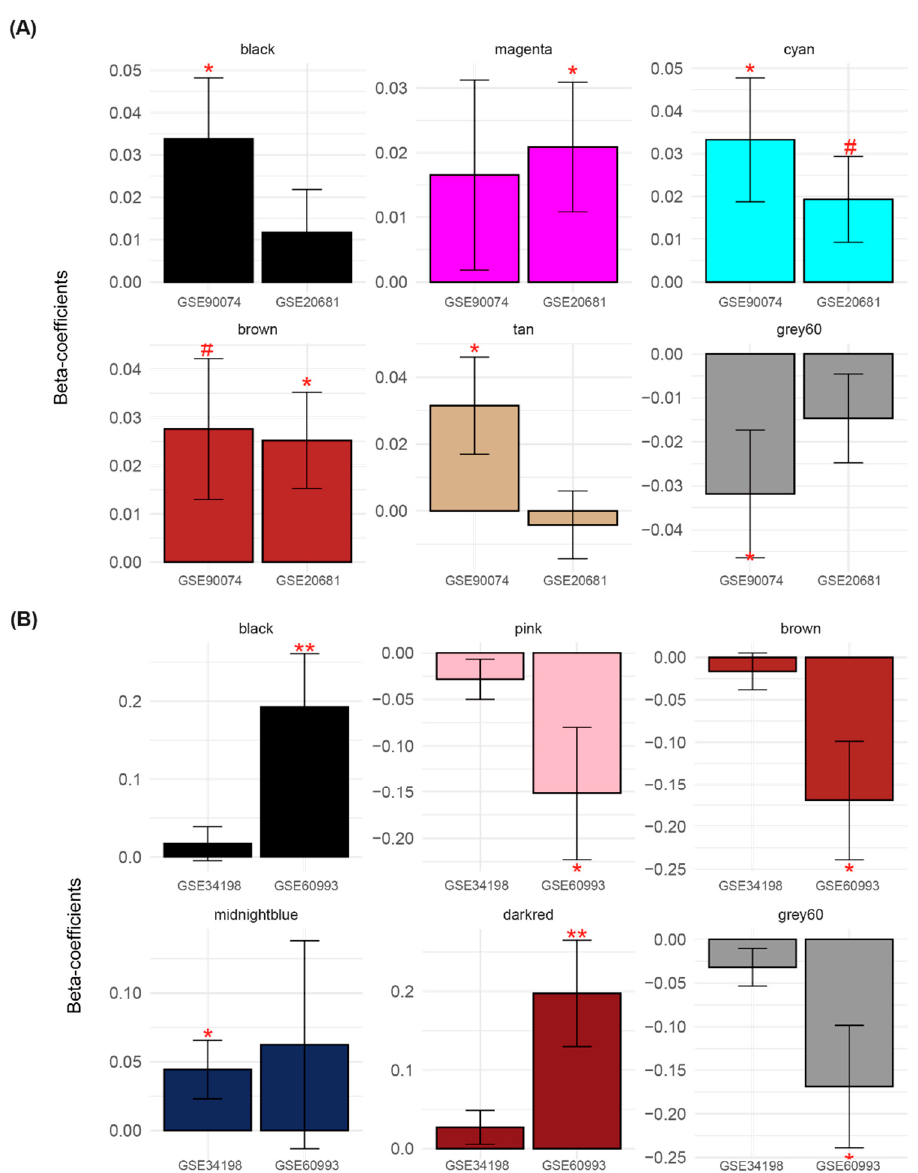
Figure 4. Selection of obstructive CAD- and ACS-related modules based on differential expression analysis. Beta-coefficients were measured from linear regression by setting MEs ( A ) and disease status ( B ) (i.e., obstructive CAD and ACS vs. matched control) as dependent and independent variables, respectively. **, *, # denote p < 0.01, p < 0.05, and p < 0.1, respectively. ME, module eigengene; CAD, coronary artery disease; ACS, acute coronary syndrome.